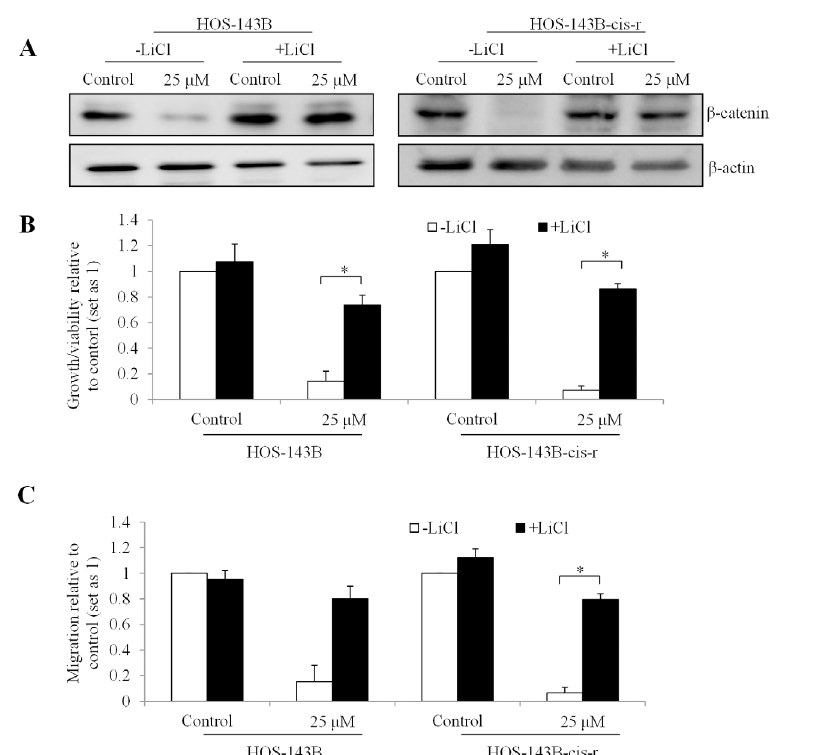
Figure 6 – LiCl reverses the inhibitory effects of niclosamide in parental and chemo-resistant osteosarcoma cells. (A) Western blot showing no change on β-catenin level by niclosamide in HOS-143B and HOS-143B-cis-r cells treated with LiCl. The addition of LiCl reverses the inhibitory effects of niclosamide in growth/viability (B) and migration (C) in HOS-143B and HOS-143B-cis-r. *, p<0.05, compared to control. Control was set up as 1. One-way analysis of variance followed by Tukey’s HSD test was conducted for multiple